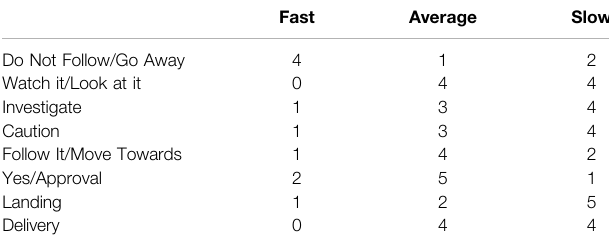
TABLE 7 | Participants ’ chosen speed of interaction by state.